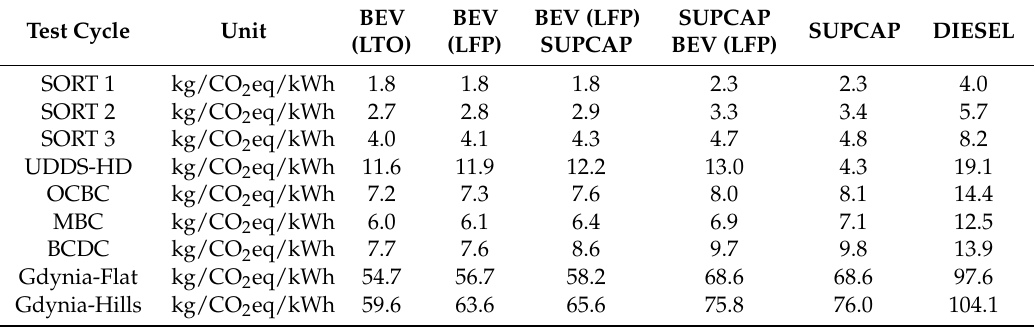
Table 6. Potential possible CO 2 emission amounts generated by a bus with each drive system configuration. Test